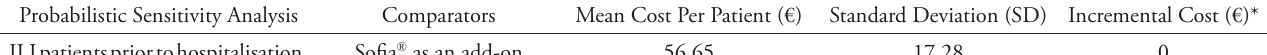
Table 4. Results of the probabilistic sensitivity analysis (Monte Carlo Simulation) Probabilistic Sensitivity